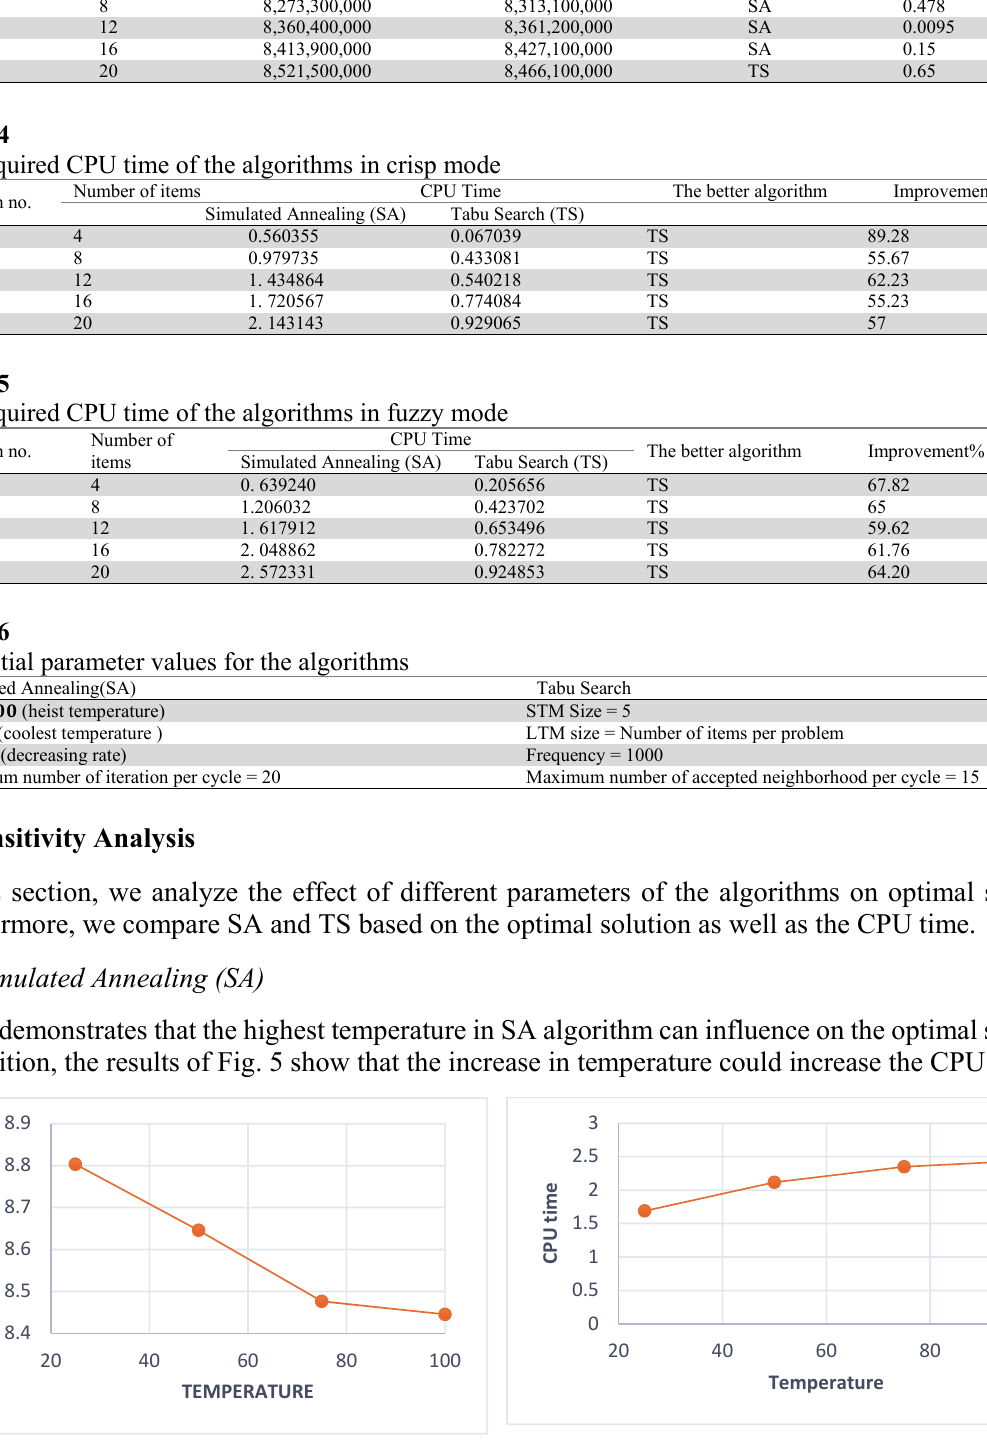
Fig. 5 . The effect of highest temperature on the CPU